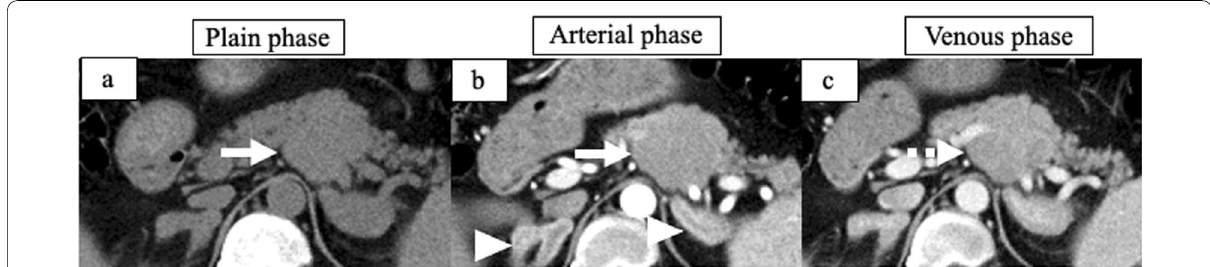
Fig. 1 Enhanced CT imaging. a Plain CT reveals the tumor located in the pancreatic tail (55 mm in diameter; white arrow). b Enhanced CT reveals the tumor with enhancement (white arrow) and bilateral adrenal enlargement (white arrowhead). c Enhanced CT reveals the tumor persisting with weak enhancement (dotted white arrow). CT computed